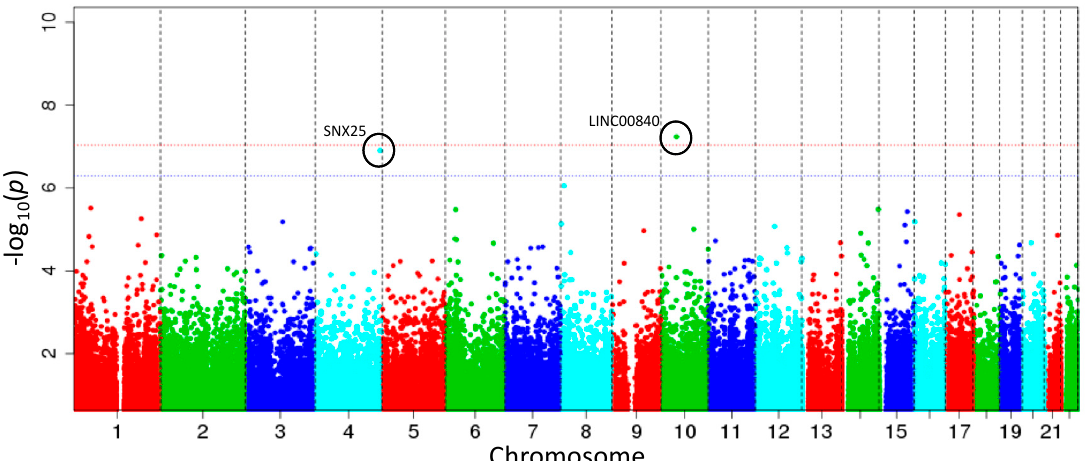
Figure 1. Genome-wide analysis of breastfeeding association with childhood DNAm. The Manhattan plot shows the association of breastfeeding duration >6 months and DNAm at 10 years. The model was adjusted for sex, birthweight, maternal age, maternal smoking at birth, maternal socioeconomic status and estimated cell type proportions. The blue and red lines indicate the FDR (false discovery rate) and Bonferroni (9.28 × 10 − 8 ) thresholds, respectively.